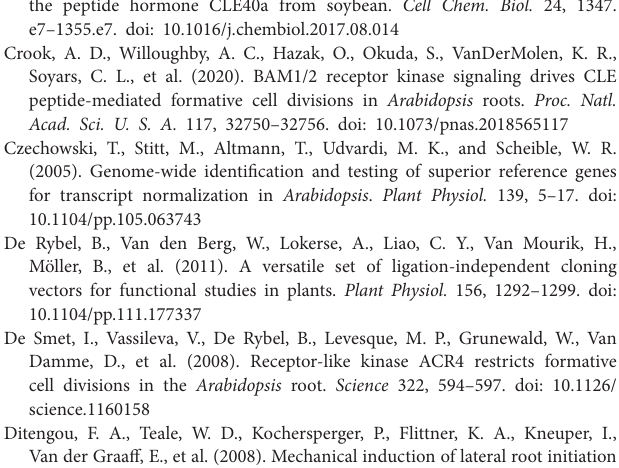
Supplementary Figure 1 | Expression patterns of CLEs identified by scRNA- seq. (A) No GFP signal detected for pCLE20:3xnlsGFP in primary root tips at 5 dpg. (B) Color-coded root cell clusters identified by scRNA-seq. (C–E) Feature plots of CLE16 (C) , CLE17 (D) , and CLE20 (E) expression in root cell types corresponding to (B) . Expression data of all three CLE genes were obtained from the scRNA-seq database online (https://bioit3.irc.ugent.be/plant-sc-atlas/). Supplementary Figure 2 | CLE16p treatment inhibits root growth. (A) Quantification of root length of the cle mutants at 5 dpg and wild-type treated with CLE16p or CLE5p. (B) Confocal images of the root tips of the indicated genotypes and the wild-type roots treated with 1 μ M CLE16p. Black arrowheads indicate the junction between meristematic and elongation zones. (C) Quantification of root meristem size of the genotypes shown in (B) . Roots were grown on agar medium supplemented with or without 1 μ M CLE16p or CLE5p for 5 days. Error bars represent SD. Student’s t -test, * p < 0.05, ** p < 0.01, and *** p < 0.001. Supplementary Figure 3 | CLE16/17 peptides do not act through CLV1-ACR4 during LR emergence. Quantification of LRE density of wild-type, clv1-20 and acr4-2 at 8 dpg treated with or without 1 μ M CLE16p for 2 days. n = 30 for each genotype. Error bars represent SD. One-way ANOVA followed by